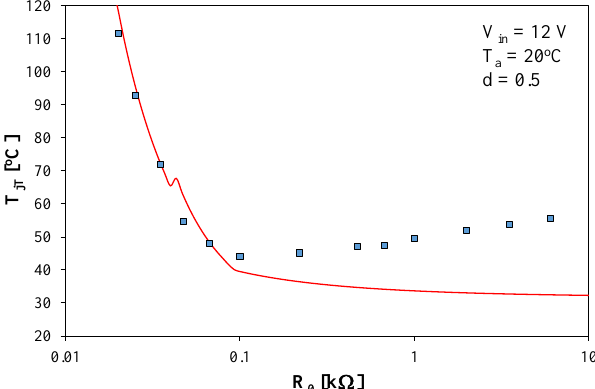
Figure 10. Computed and measured dependence of internal temperature of IGBT on load resistance.